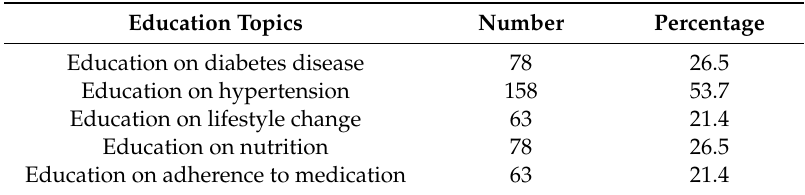
Table 7. Education topics discussed with community health volunteer N =